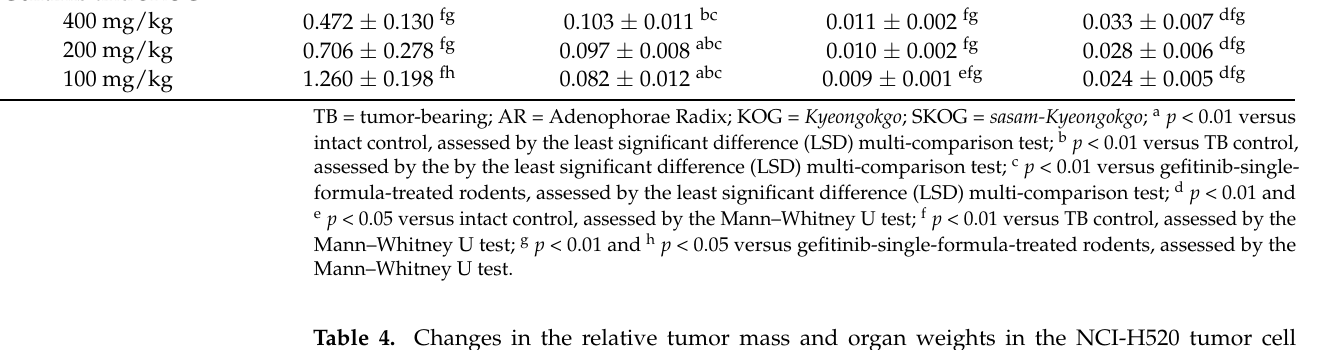
Table 4. Changes in the relative tumor mass and organ weights in the NCI-H520 tumor cell xenograft